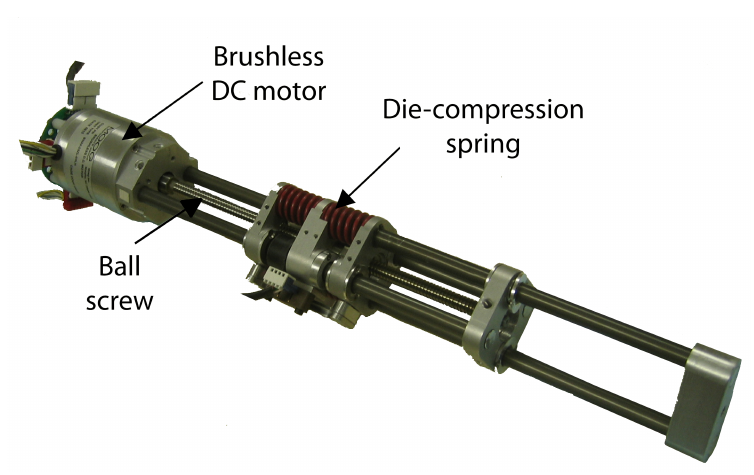
Figure 14. Yobotics SEA23-23.